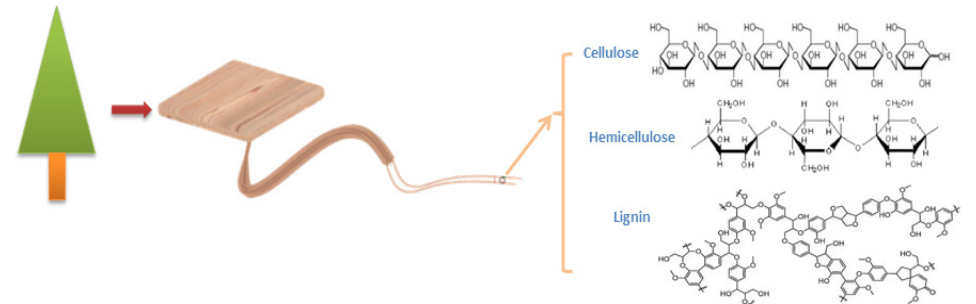
Figure 1. Xylem structure.